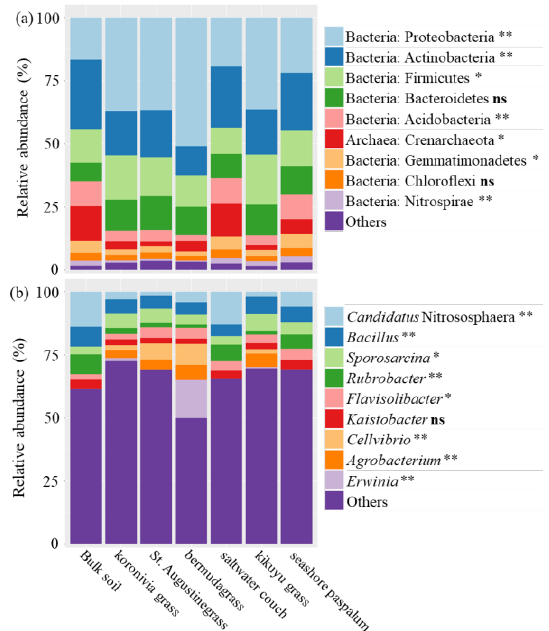
Figure 4. Taxonomic composition of bacterial communities in bulk soil and rhizosphere soil of six perennial grasses. Taxonomic resolution was at ( a ) phylum level and ( b ) genus level. The top 9 most abundant taxonomic groups are presented. The effect of treatment was tested as: ns: not significant, *: significant at p < 0.05, and **: significant at p < 0.01. p -values were adjusted by Benjamini–Hochberg FDR.